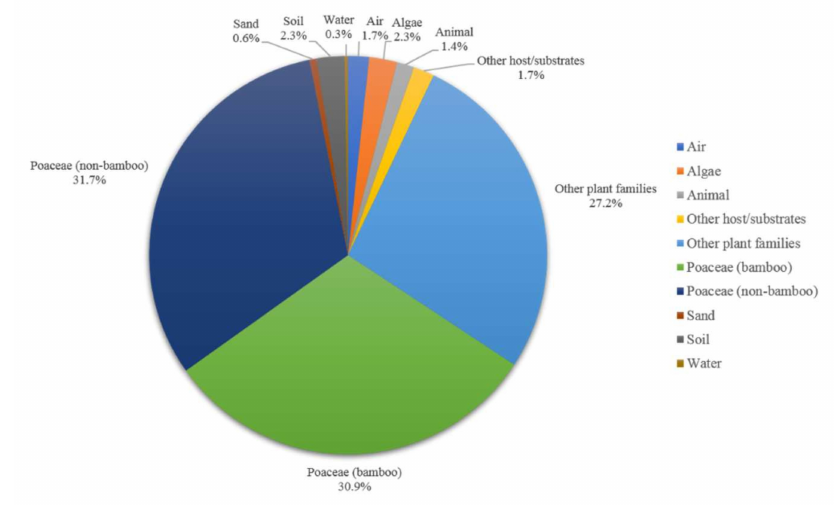
Figure 6. Host-substratum diversity of Apiospora